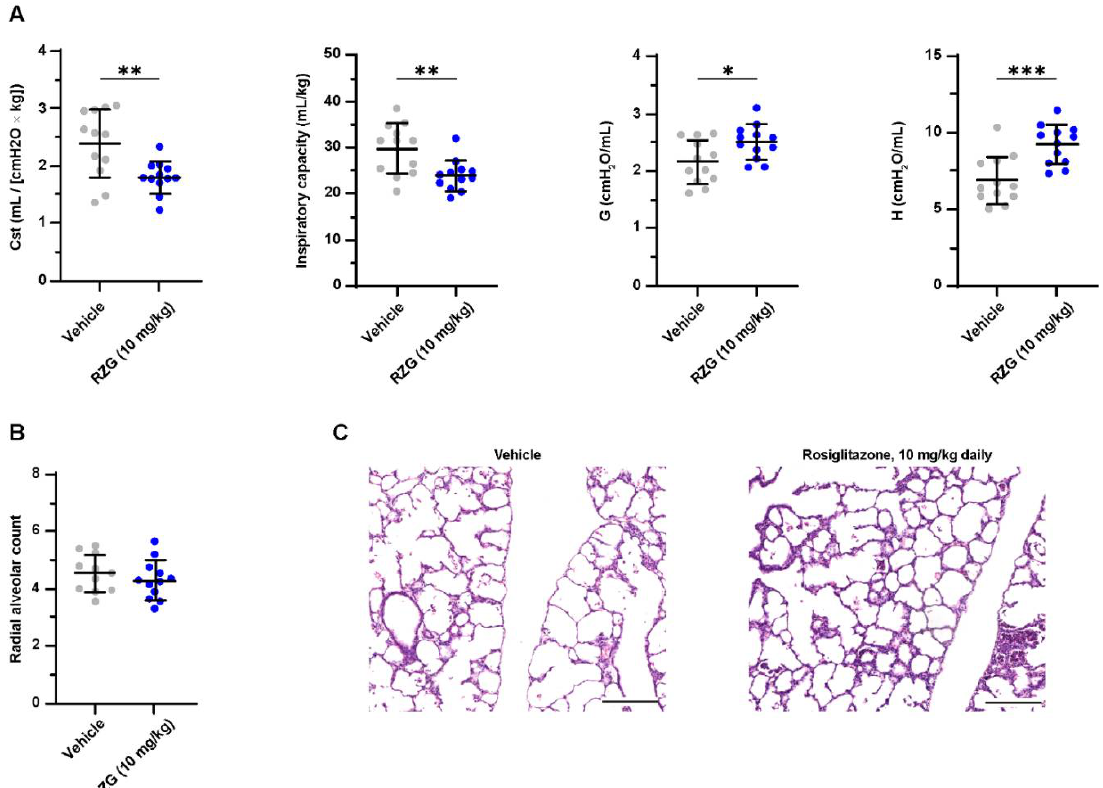
Figure 5. ( A ) Static compliance (C st ), total inspiratory capacity, lung tissue damping (G), and tissue elastance (H) at post-natal day 7 in preterm rabbits exposed to hyperoxia (95% oxygen) treated with daily intraperitoneal rosiglitazone (10 mg/kg) or vehicle. ( B ) Radial alveolar count and ( C ) representative hematoxylin–eosin-stained lung sections at post-natal day 7 (scale bar: 200 µ m). Comparisons between groups were performed using the unpaired, two-sided t-test. * p < 0.05; ** p < 0.01; and *** p < 0.001.